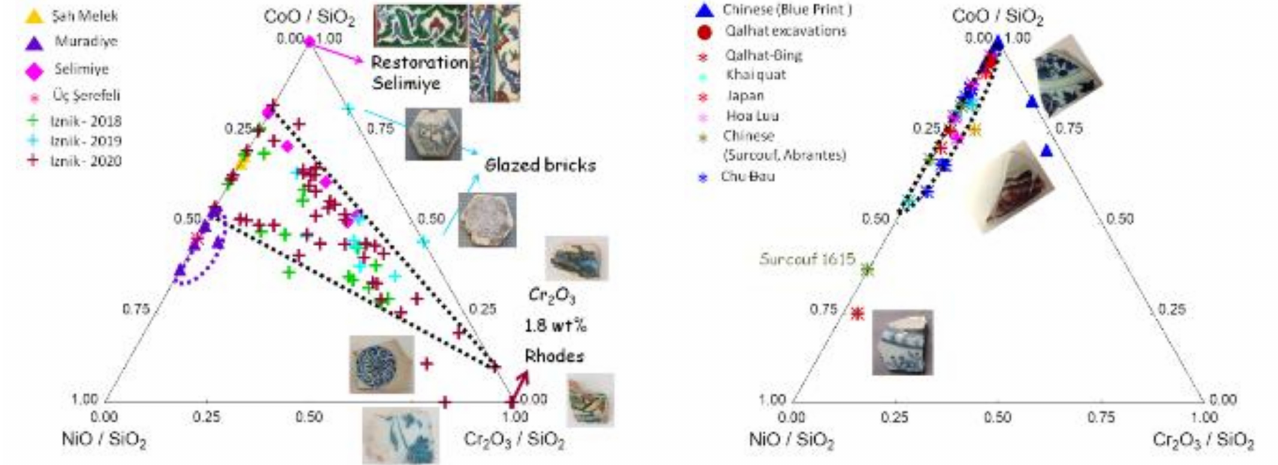
Figure 9. Comparison of the variability of Cr 2 O 3 content measured on Chinese/Vietnamese sherds and Iznik sherds/tiles (please refer to Figures 7 and